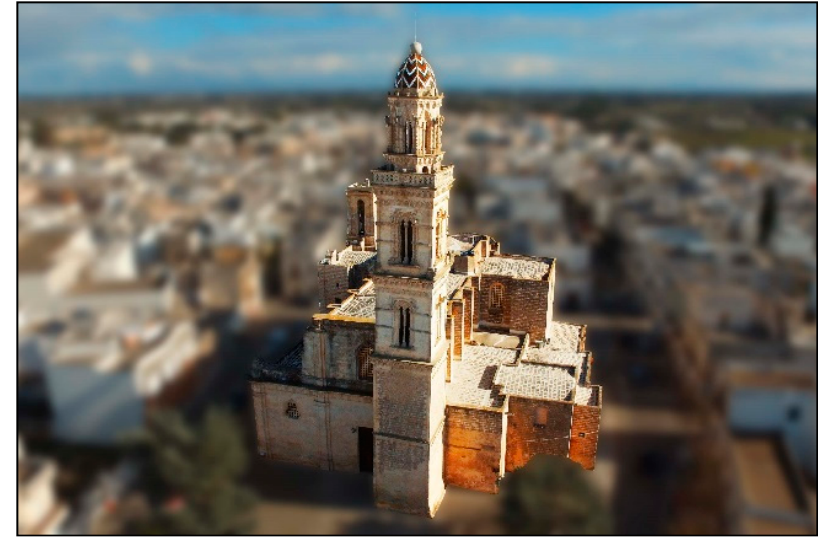
Figure 1. Bird’s eye view of the Soleto’s bell-tower.